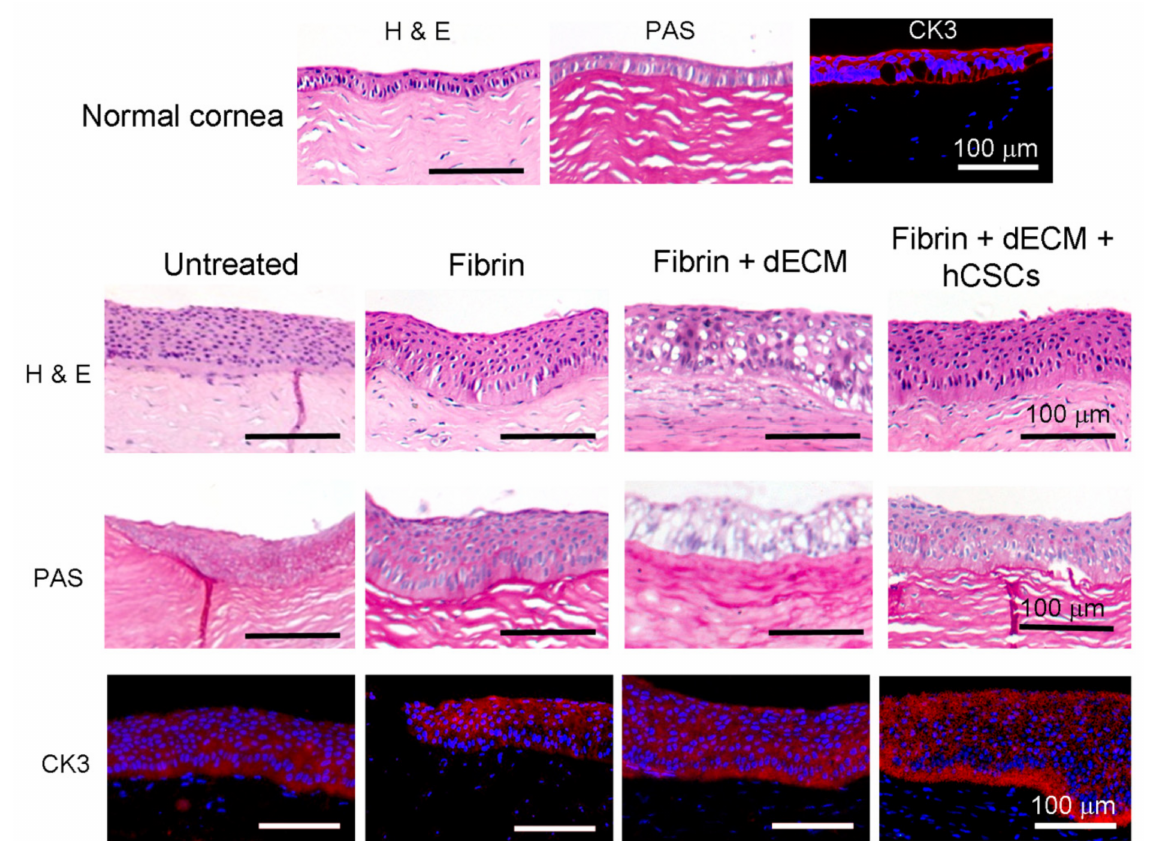
Figure 5. Histopathology and immunofluorescence imaging of paraffin-embedded rabbit cornea sections. H&E imaging revealed strong adhesion of the fibrin-based adhesives to the cornea and demonstrated evidence of re-epithelialization and stromal reconstruction with signs of epithelial hyperplasia. PAS staining denoted the absence of goblet cell infiltration in the cornea. Immunofluorescence staining demonstrated a positive stain for cytokeratin 3, observed across all groups, confirming corneal re-epithelialization by the end of eight